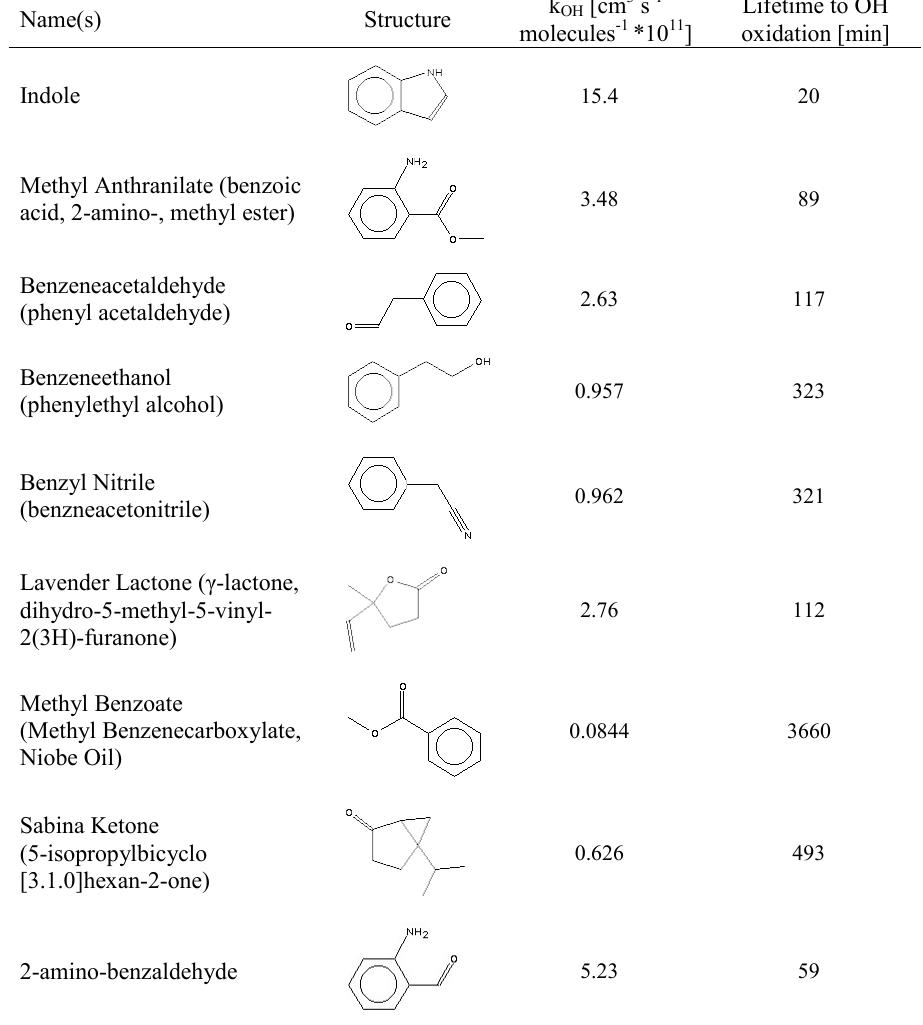
Table 4. Novel compounds from measurements of ambient air during